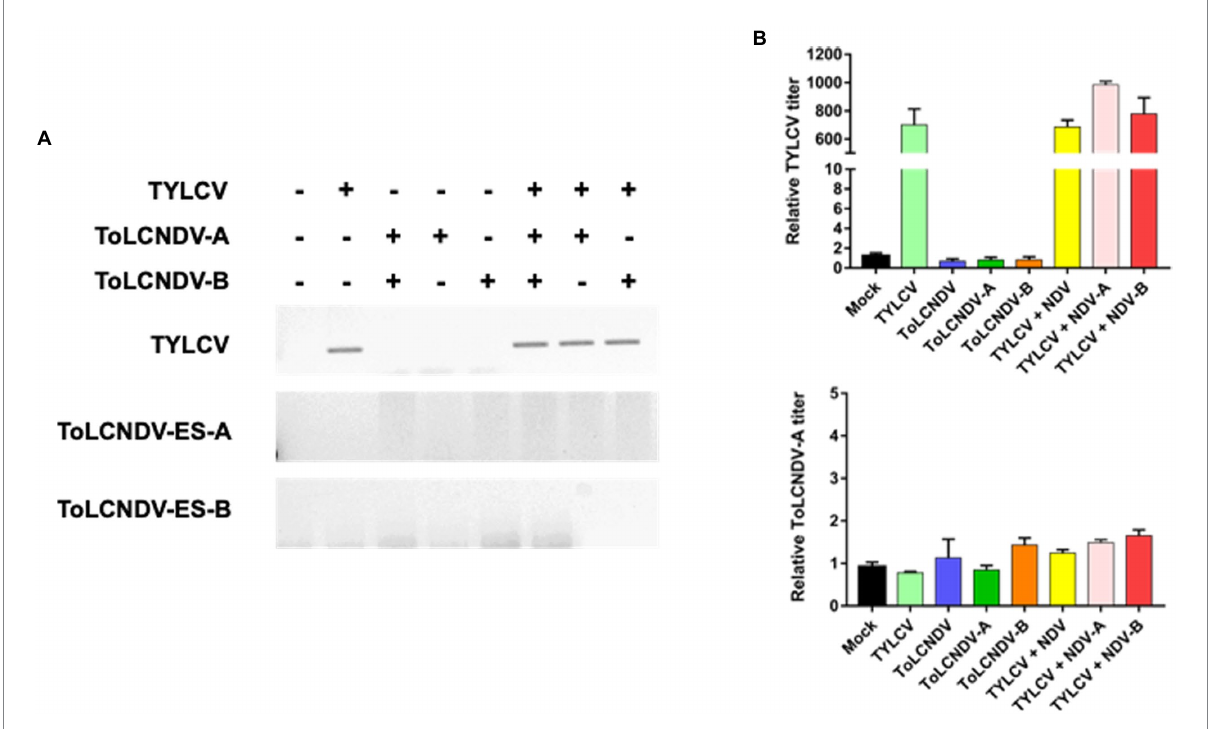
FIGURE 6 Mixed inoculation of TYLCV and ToLCNDV on TYLCV resistance tomato cultivar “Bacchus”: (A) detection of the virus by PCR. In the resistance plants, TYLCV accumulation was reduced and no ToLCNDV was found in the association with the presence (+) or absence ( − ) of TYLCV; (B) relative TYLCV and ToLCNDV amounts on co-inoculated plants were conducted via qPCR. Titer in mock plants was normalized to 1. Co- inoculation between TYLCV and ToLCNDV-ES did not result in a significant change in the TYLCV titer compared to a single